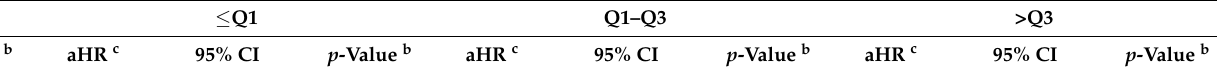
Table 5. Impact of socioeconomic status on death risk of colorectal cancer